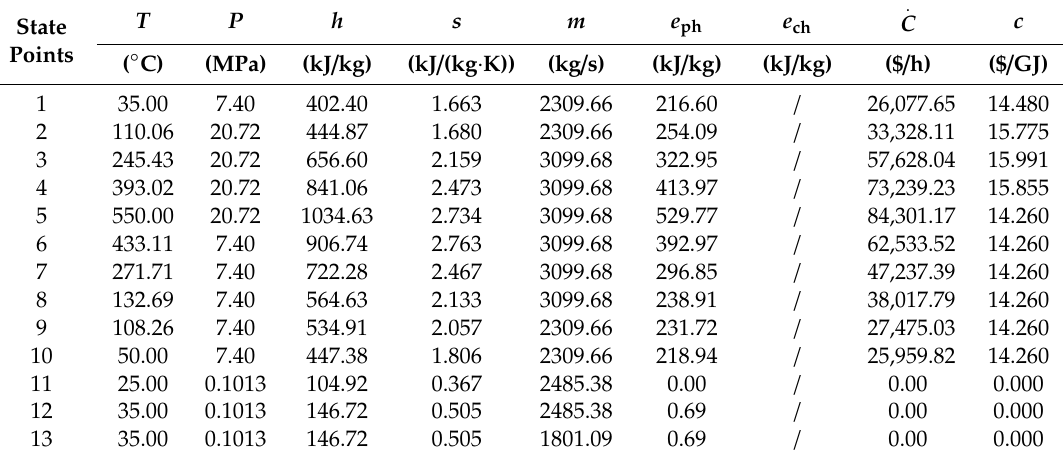
Table 11. Thermodynamic properties and costs of exergy streams for the sCO 2 / ammonia-water AHP